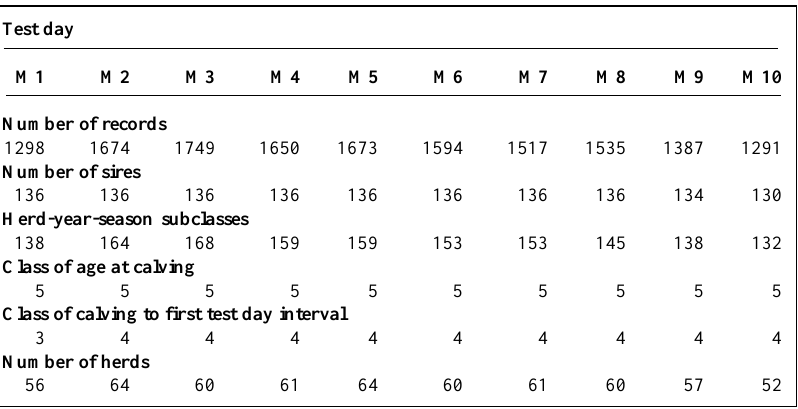
Table I - The data set structure for the analysis of test day milk yields (M1-M10) in first lactations of Holstein cows.* Test